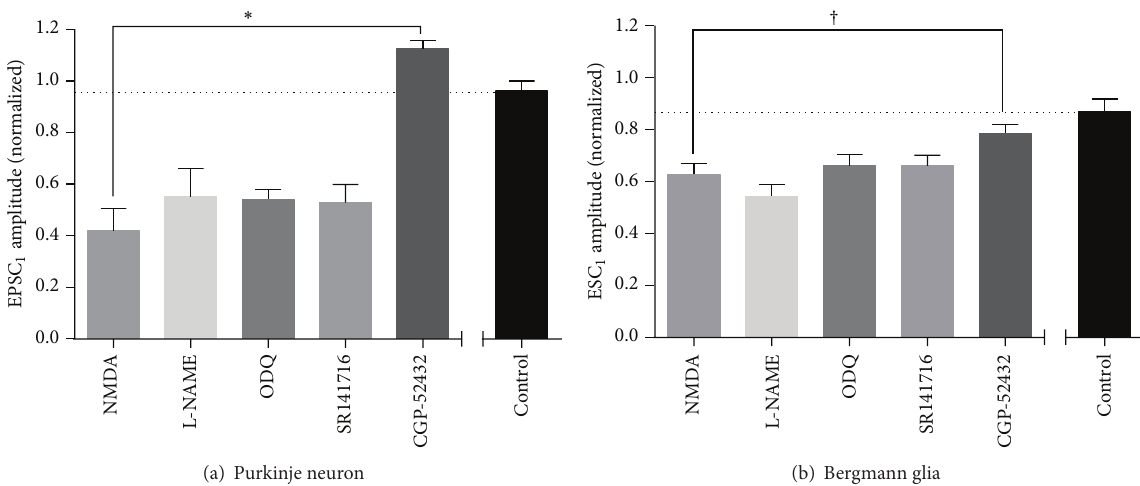
Figure 10: Modulation of NMDA-induced depression of neuronal and glial currents. (a) Mean EPSC 1 amplitude following incubation with 30 𝜇 M NMDA and 10 𝜇 M glycine, either alone or in the presence of the stated inhibitors (L-NAME, 100 𝜇 M; ODQ, 10 𝜇 M; SR141716, 5 𝜇 M; CPG 52432, 10 𝜇 M). Control data from untreated cells stimulated for the same period are provided for reference. Data are mean ± s.e.m. from 5–7 cells. Statistical significance was tested by Dunnett’s multiple comparisons test following one-way ANOVA. (b) Mean ESC 1 amplitude following incubation with 30 𝜇 M NMDA and 10 𝜇 M glycine, either alone or in the presence of the stated inhibitors (L-NAME, 100 𝜇 M; ODQ, 10 𝜇 M; SR141716, 5 𝜇 M; CPG 52432, 10 𝜇 M). Control data are provided for reference. Data are mean ± s.e.m. from 5–9 cells. Statistical significance was tested by Dunnett’s multiple comparisons test following one-way ANOVA. ∗ 𝑃 < 0.0001 ; † 𝑃 = 0.0105